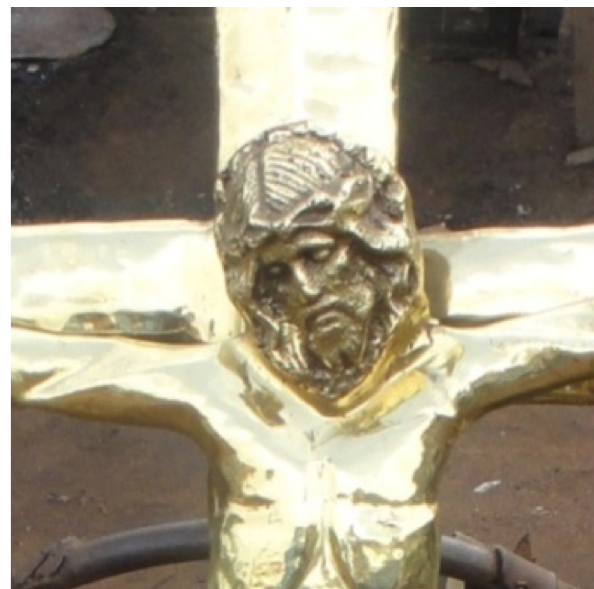
Figure 11 | A copper alloy crucifix fabricated from sheet metal working as well as metal casting. Photograph by Kingsley O. Emeriewen,